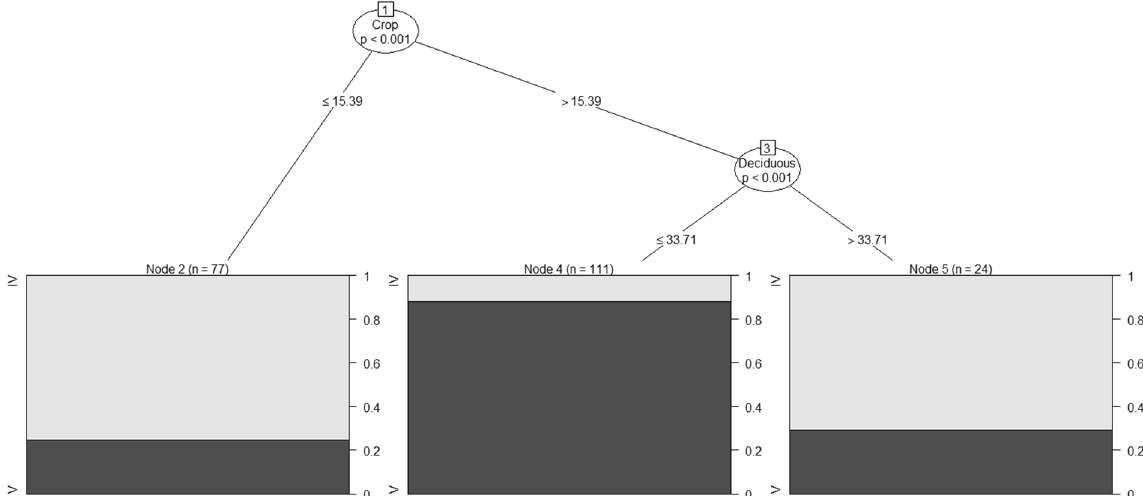
Figure 3. Classification tree showing the relative importance of the different biological and environmental attributes, with statistically significant branches at Nodes, in determining the Body Condition score, on a scale of I to V, of SM males in all-male groups. SM: Sexually Mature but Socially